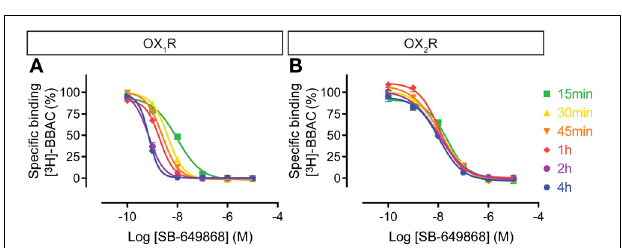
FIGURE 3 | Effect of time on BBAC ((S)-N-([1,1 (cid:2) -biphenyl]-2-yl) -1-(2-((1-methyl-1H-benzo[d]imidazol-2-yl)thio)acetyl)pyrrolidine-2- carboxamide) competition for [ 3 H]-BBAC binding to membranes from CHO cells expressing human (A) OX 1 R or (B) OX 2 R. Data is representative of triplicate determinations and error bars indicate s.e.m.